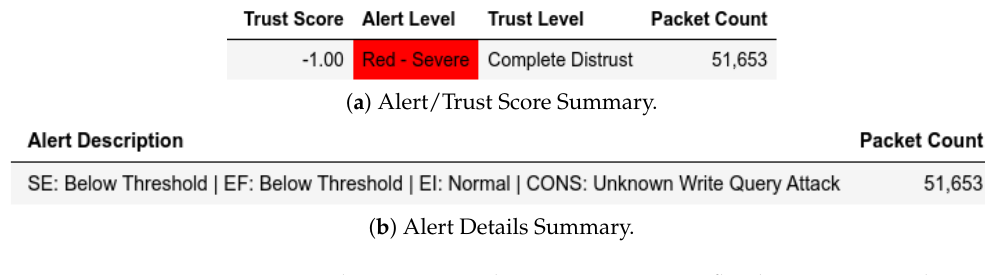
Figure 28. ATENA H2020 dataset internal test- H a in query flooding capture-unknown write attack.